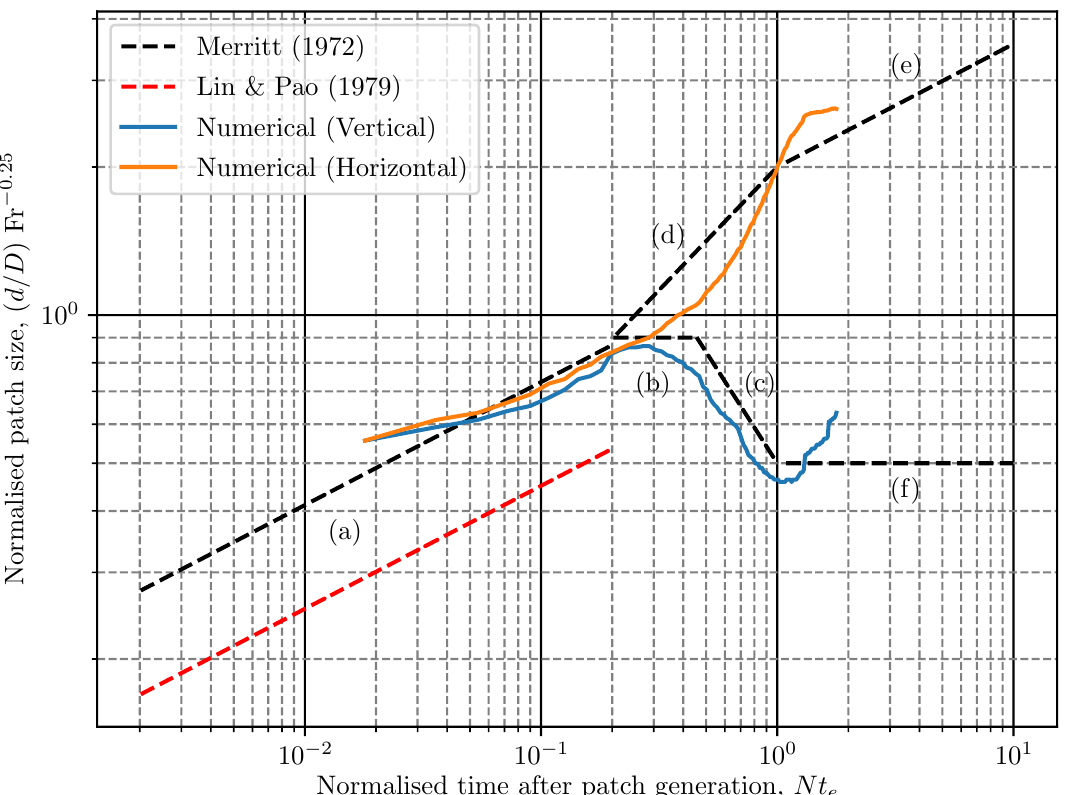
Figure 6. The evolution of the height and width of the mixed patch. Note that t e represents the elapsed time since the mixed patch was generated (i.e., the elapsed time following the passage of the propeller). The scaling laws of Merritt [4] and Lin & Pao [5], labelled (a) to (f), are included for